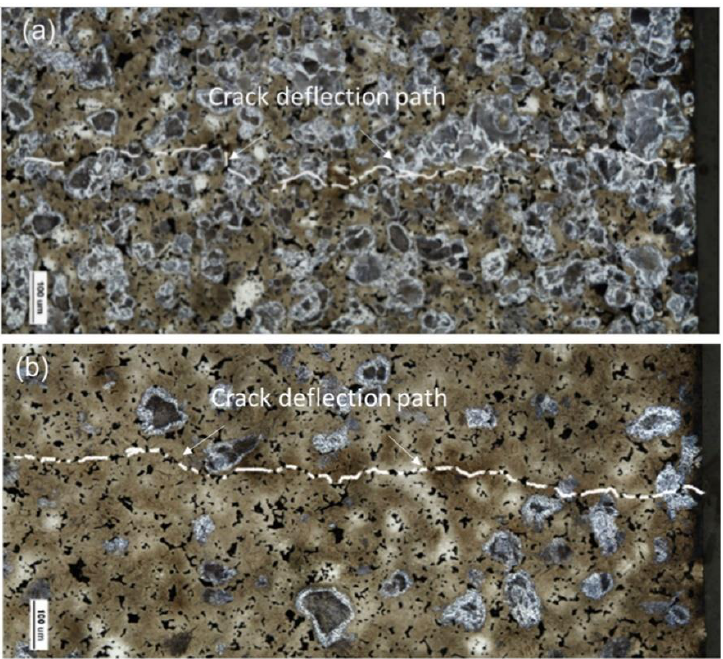
Figure 7. The propagation of fatigue cracks in Distaloy AE alloy steel sintered at ( a ) 1120 °C and ( b ) 1250 °C.